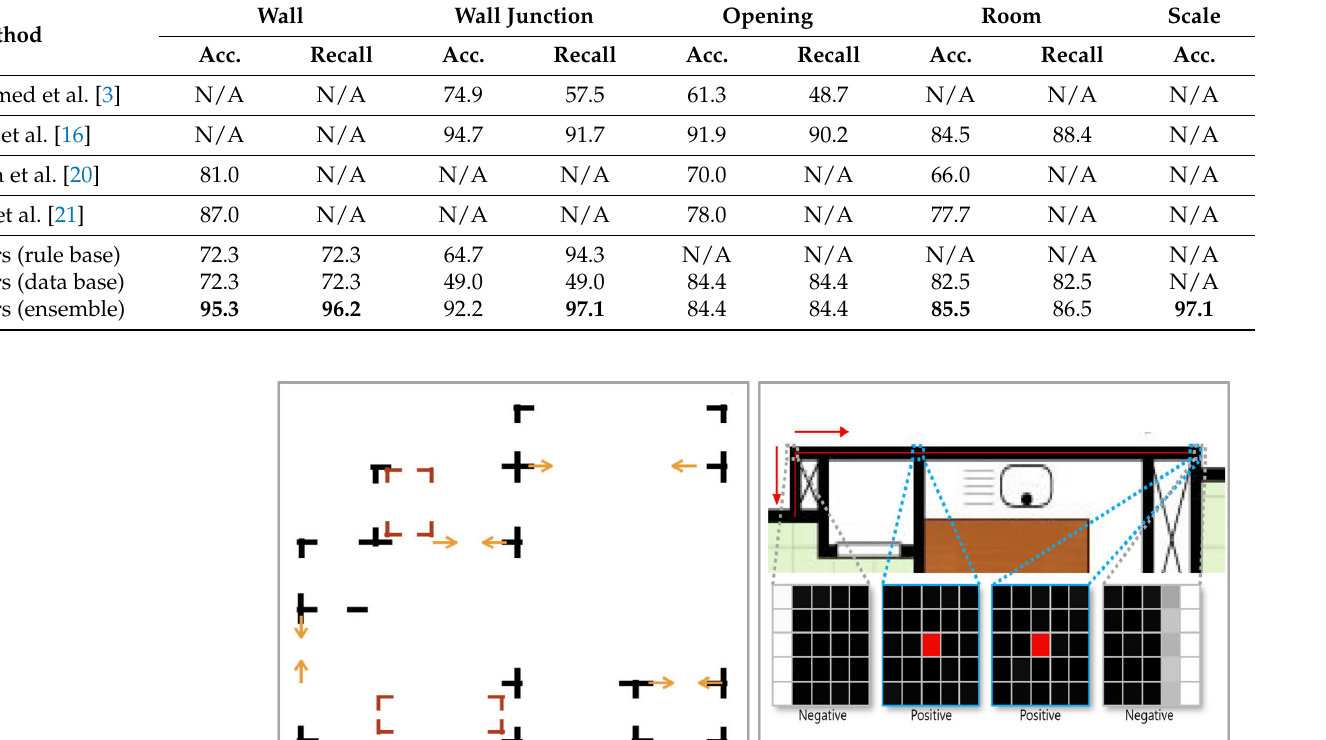
Table 1. Object generation accuracy/recall.